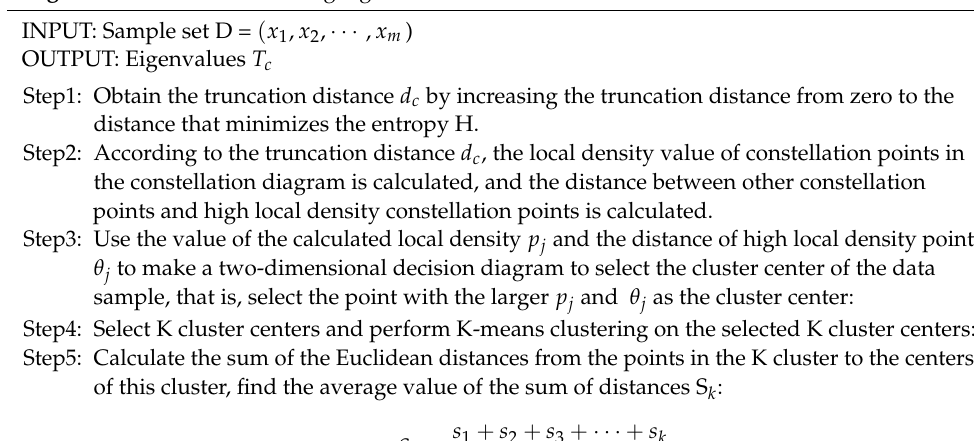
Algorithm 2 KADPC clustering